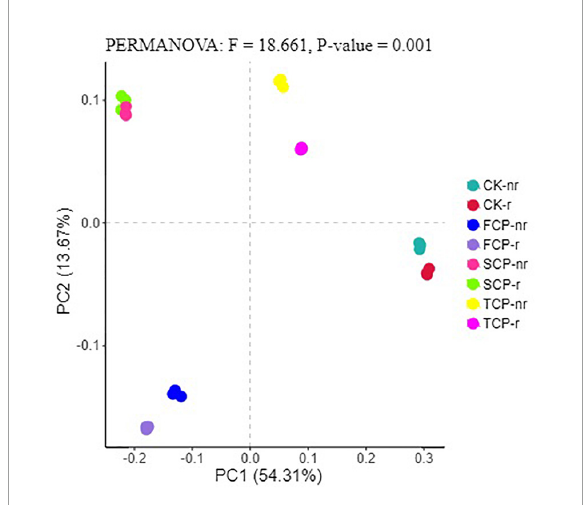
FIGURE6 Principal coordinate analysis (PCoA) for bacterial in different fir seedings and soil types (using combined rhizosphere soil and bulk soil data). Data were obtained from different successive planting generations and soil types CK, Nanmu seedings; FCP, first generation seedings; SCP, second-generation seedings; TCP, third-generation seedings; r, rhizosphere soil; nr, bulk soil.